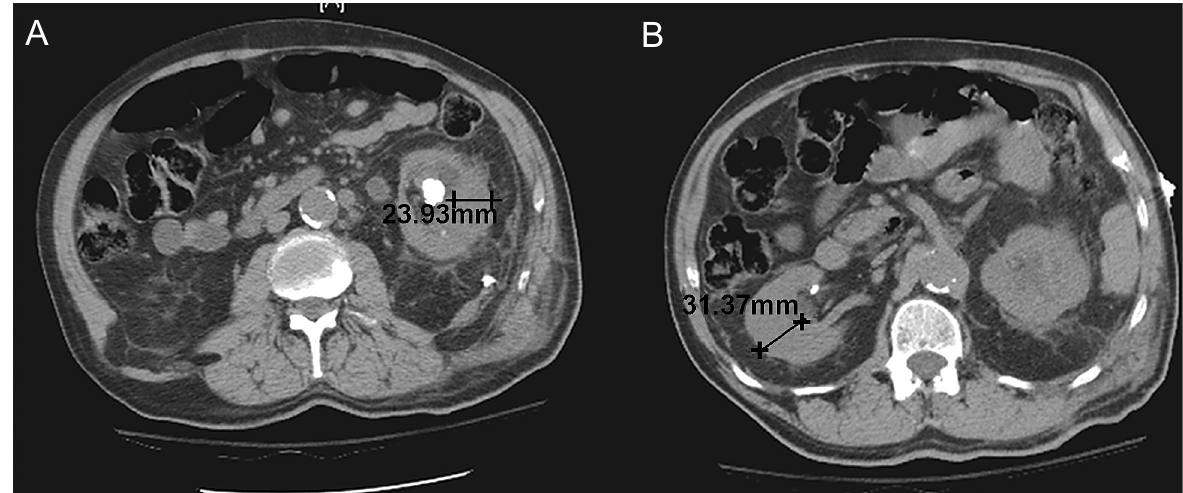
Figure 1 – Measurement of renal parenchyma thickness for obstructed renal unit (A) and non-obstructed renal unit